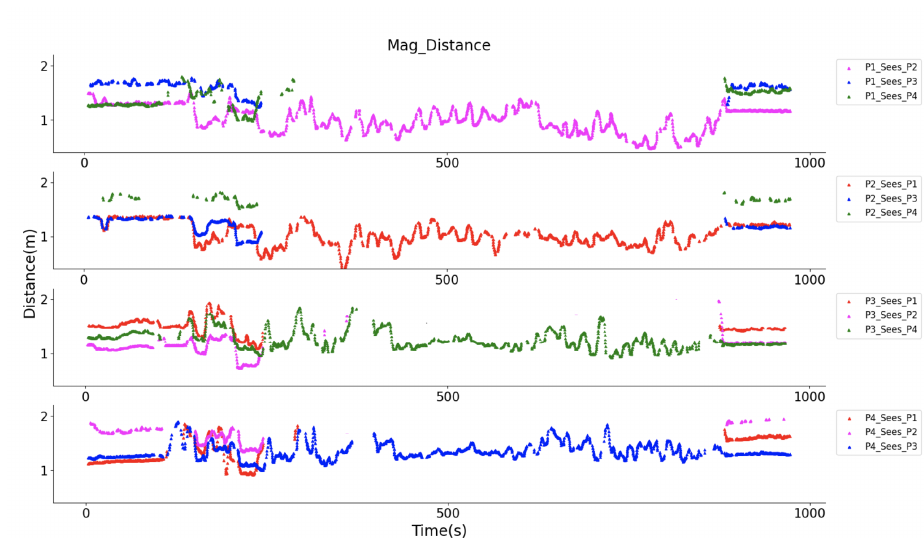
Figure 23. Distance tracking of four volunteers in a construction material supermarket, where at the beginning and end they gathered together, and during the mid-time they kept a group distance of beyond 3 m.